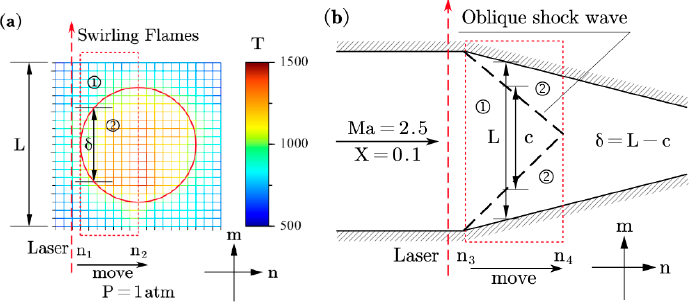
Figure 7. Schematic of the case working conditions: ( a ) swirl flame and ( b ) inlet oblique shock. Table 1. Physical parameters of the flow field under two working conditions. Work Condition